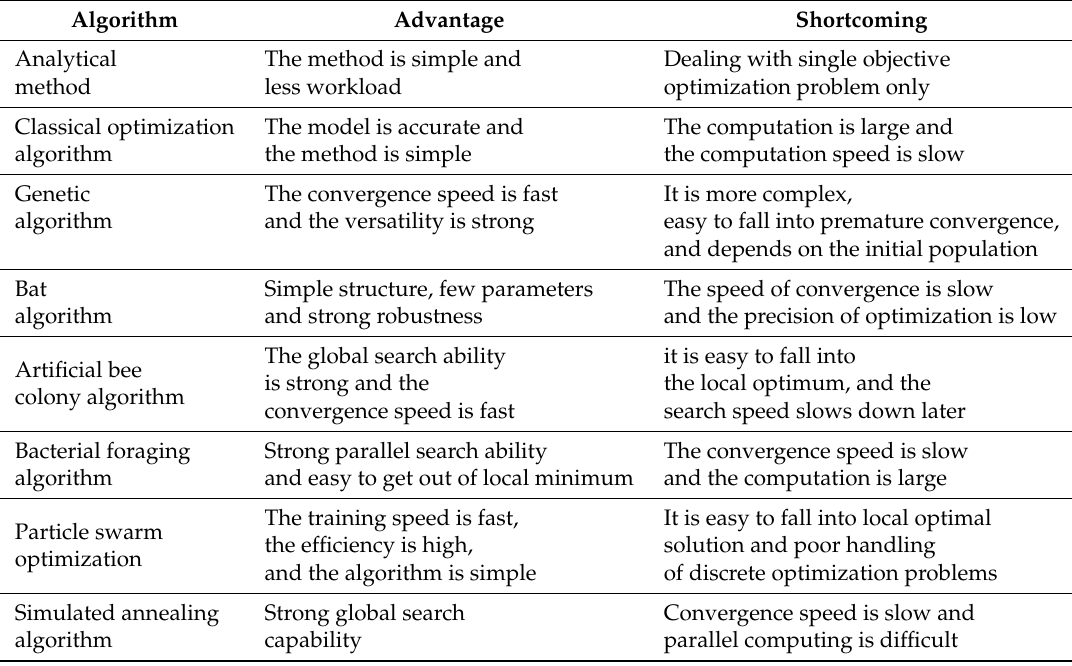
Table 1. Advantages and disadvantages of various